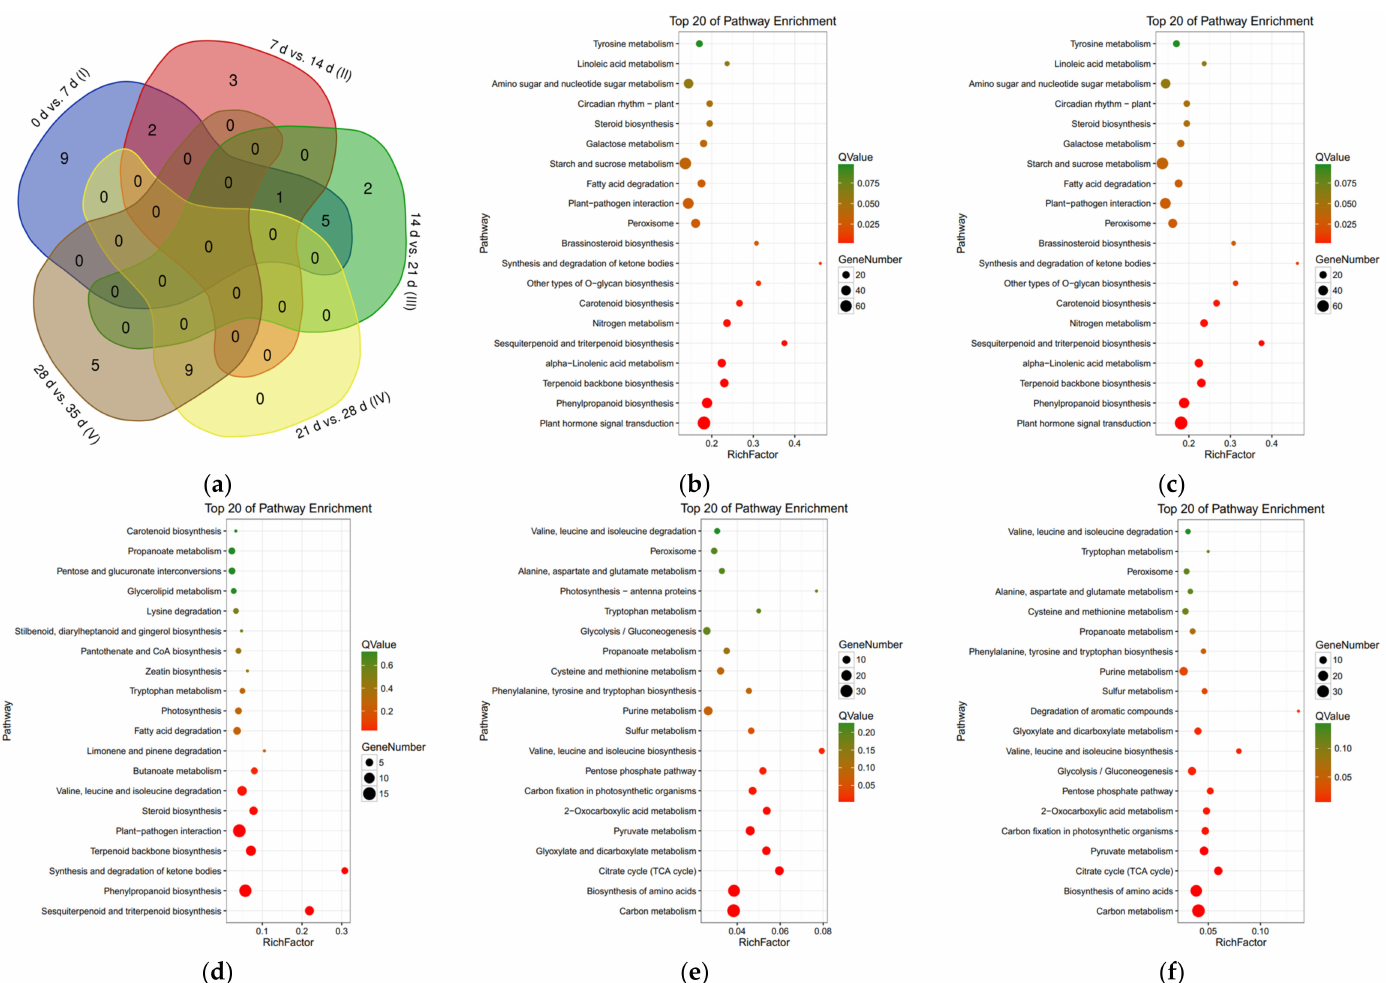
Figure 4. The KEGG enrichment analysis of DEGs in five stages of cold-stored loquat fruits. ( a ) Venn programs showed the overlapped enriched KEGG pathways among different stages; ( b ) 0 days vs. 7 days (I); ( c ) 7 days vs. 14 days (II); ( d ) 14 days vs. 21 days (III); ( e ), 21 days vs. 28 days (IV); ( f ) 28 days vs. 35 days